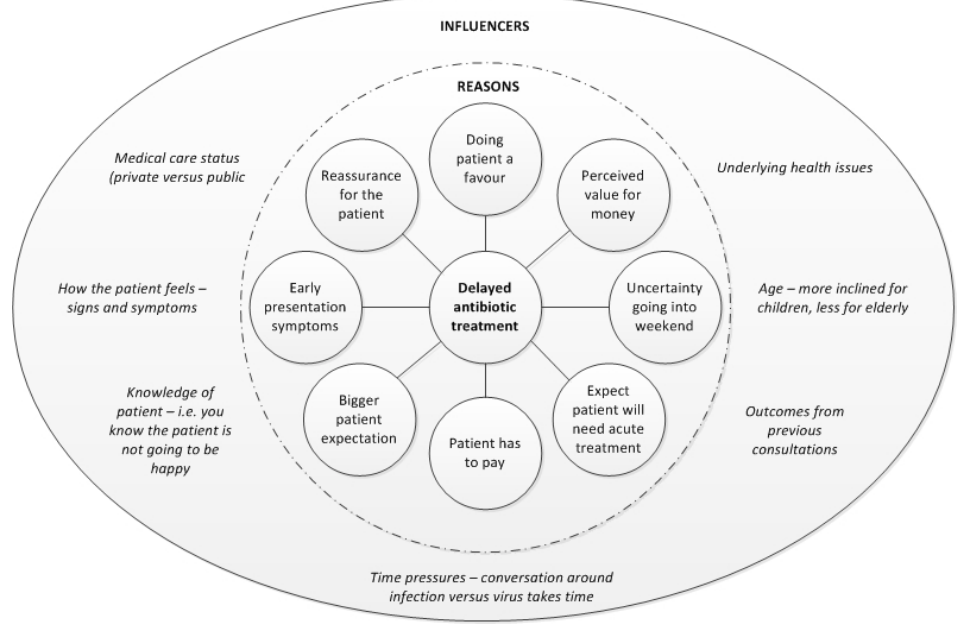
Figure 1. Motivators and Influences on GPs decision to provide a delayed antibiotic prescription.